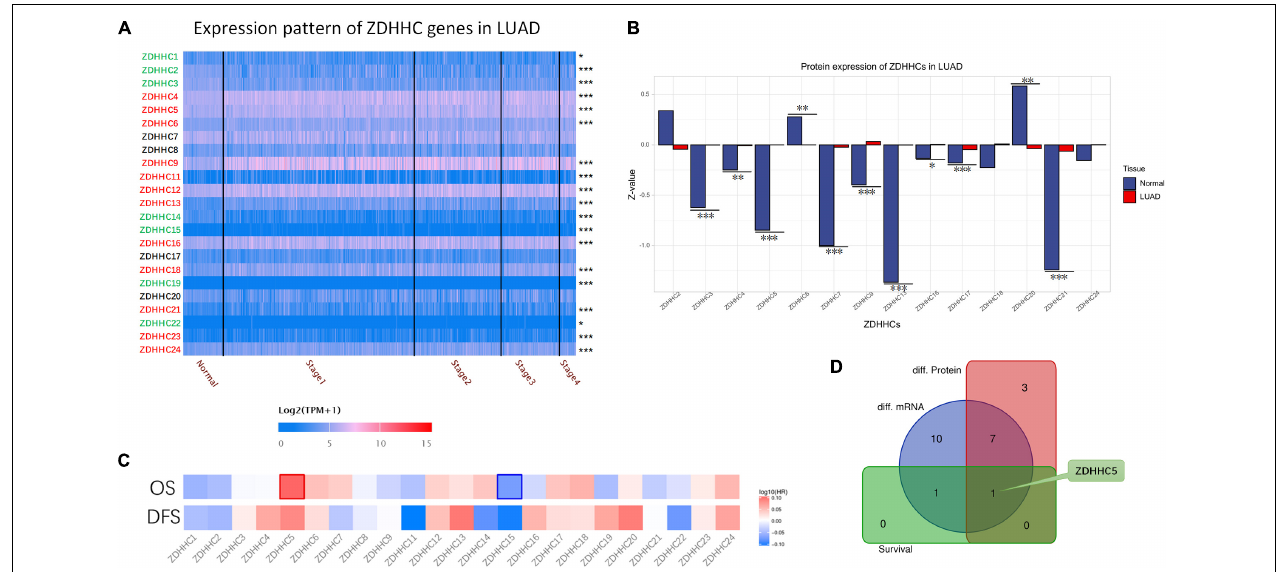
FIGURE 1 | General profiling of ZDHHCs family gene expression and survival analysis in LUAD. (A) The heat map shows the RNA-seq results of ZDHHC mRNA in cases from the LUAD data set of TCGA. The LUAD cases are shown separately by clinical stages. The ZDHHCs coding in green indicate lower expression of the LUAD cases than normal tissues, and the red indicates higher expression. The color of scale bar presents high (red) and low (blue) expression, respectively, and the intensity of color indicates the value of mRNA expression. (B) The differential proteomic expression of ZDHHCs in LUAD cases from the CPTAC database. In the bar plot, the length of the bar represents the normalized expression ( Z-value ) of ZDHHC in LUAD. The color of the bar presents LUAD (red) and normal lung (blue). (C) Heat map of log 10 (HR) illustrating the prognosis of ZDHHCs in LUAD patients from the TCGA database. The scale bar presents high (red) and low (blue) risk, respectively, and the intensity indicates the HR. The bounding box around the tiles represent statistically significant cancer types (HR > 1, P < 0.05). HR, hazard ratio; OS, overall survival; DFS, disease free survival. (D) The Venn diagram shows the mapping results of 3 ZDHHC gene sets. Purple, ZDHHCs that are differentially expressed at the mRNA level; red, ZDHHCs that are differentially expressed at the protein level; green, ZDHHCs with prognostic value. * P < 0.05, ** P < 0.01, *** P <